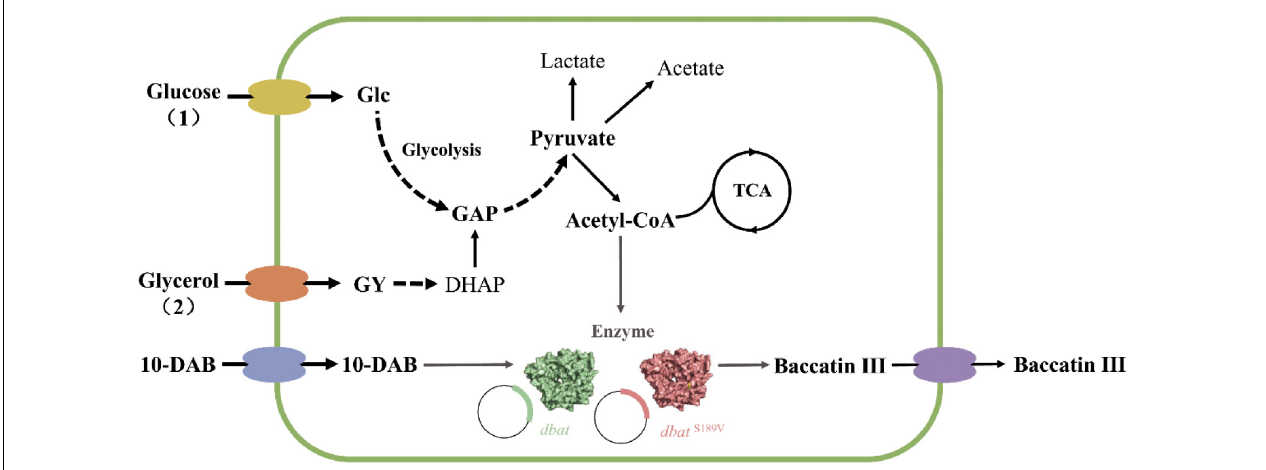
FIGURE 1 | Process for whole-cell bioconversion of baccatin III by wild-type DBAT (WT) and DBAT S189V in E. coli . (1) Producing baccatin III using glucose as a carbon source. Glucose is metabolized to produce pyruvate, which in turn, produces acetyl-CoA, which provides acetyl groups for 10-DAB to produce baccatin III. (2) Producing baccatin III using glycerol as a carbon source. Glycerol is metabolized to produce DHAP, then metabolized by glycolysis to produce pyruvate, which in turn, produces acetyl-CoA, which provides acetyl groups for 10-DAB, and produces baccatin III. The dotted arrow indicates that the multi-step reaction process is omitted in this metabolic pathway diagram. The gray arrow points to the direction of the enzymatic reaction to produce baccatin III. DBAT and DBAT S189V were overexpressed in E. coli by recombinant plasmids. Glc glucose, GY glycerol; GAP, glyceraldehyde-3-phosphate; DHAP, dihydroxyacetone phosphate; 10-DAB,